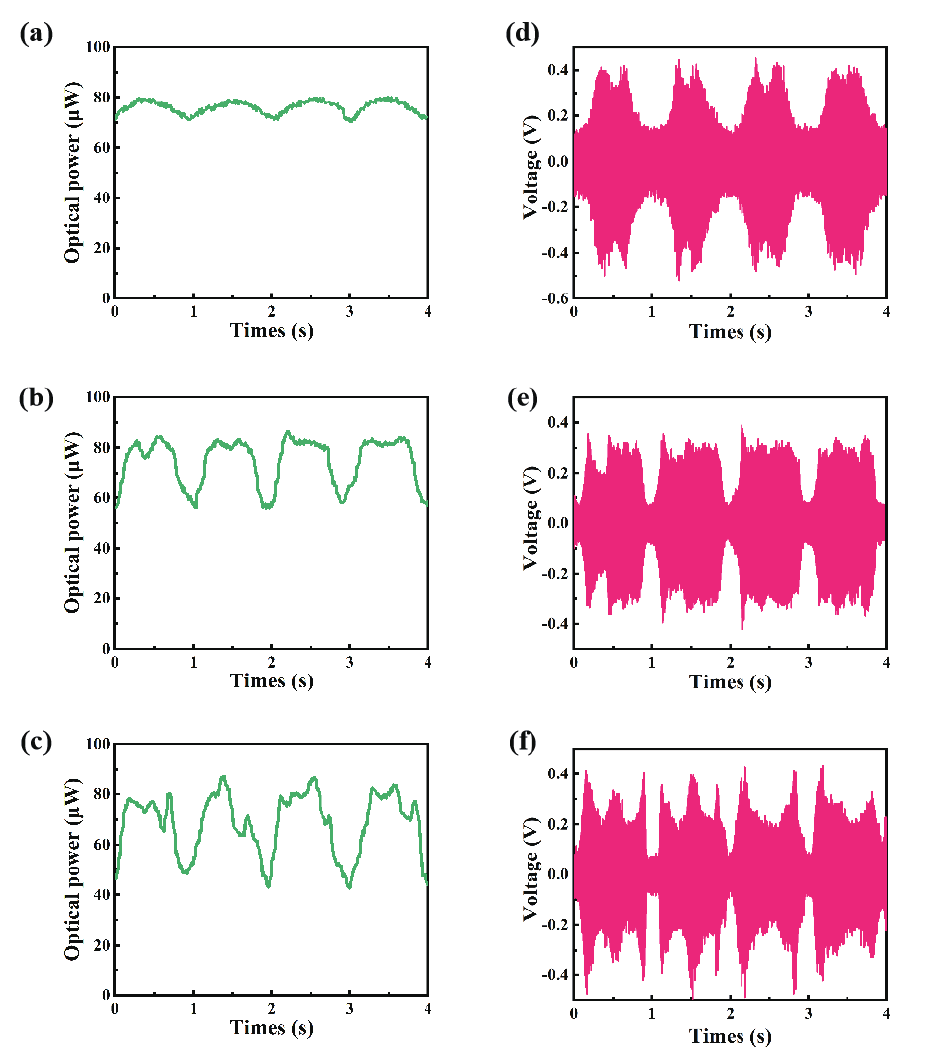
Figure 11. Optical power variation curve versus different waves amplitudes of ( a ) 10 µ W, ( b ) 20 µ W and ( c ) 40 µ W; waveform diagram versus different optical power variation amplitudes of ( d ) 10 µ W at data rate of 290 Mb/s, ( e ) 20 µ W at data rate of 240 Mb/s and ( f ) 40 µ W at a data rate of 210 Mb/s.